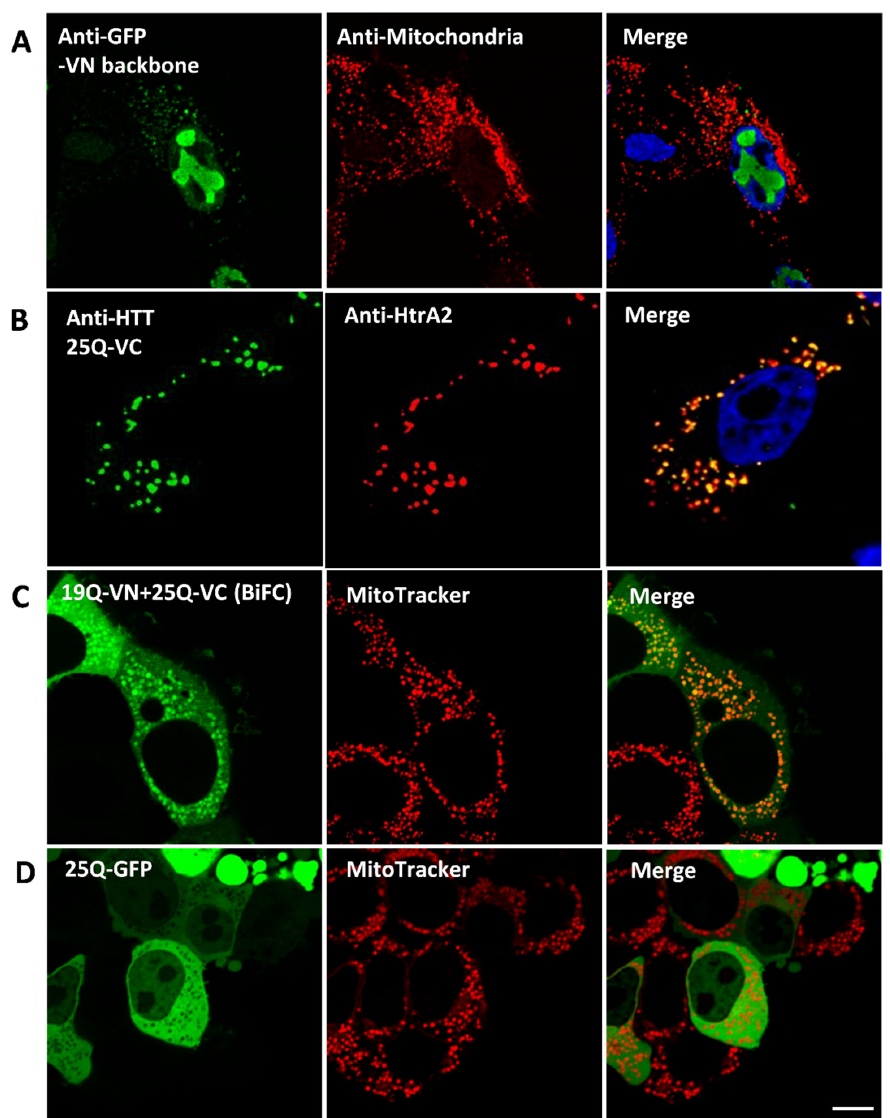
Figure 6. Fluorescence tag effect on wild type HTT subcellular localisation in fixed HEK293T cells transfected with various constructs for 48 h. ( A ) N-terminal half of Venus (VN) localisation in dual immunolabelled HEK293T cells. Left panel: anti-GFP (ab6556) (Alexa Fluor 555). Middle panel: anti-mitochondria antibody (MAB1273) (Alexa Flour 647). Right panel: merge of VN and mitochondrial signals, nuclei stained with Hoechst 33342. VN localises mostly in the nucleus, with minor punctate staining in the cytosol which co-localises with mitochondria. ( B ) Cells expressing 25Q-VC were double immunolabelled as follows: Left panel: anti-HTT (mEM48) antibody (MAB5374) (Alexa Fluor 647). Middle panel: anti-HtrA2/Omi antibody (AF1458) (Alexa Fluor 555). Right panel: merge of HTT and HtrA2 signals; nuclei were stained with Hoechst 33342. 25Q-VC co-localises with mitochondria. ( C , D ) Cells were seeded in ibiTreat dishes and co-transfected for 48 h with 19Q-VN and 25Q-VC ( C ) or 25Q-GFP ( D ). Live cells were stained with MitoTracker Red CMXRox (M-7512) prior to confocal examination. Acquired images were deconvolved. ( C ) Left panel: BiFC signal 19Q-VN and 25Q-VC. Middle panel: MitoTracker signal. Right panel: merge of BiFC and MitoTracker signals. BiFC signal of WT HTT is mitochondrial (indicated by the co-localisation with MitoTracker) as well as cytosolic. ( D ) Left panel: GFP signal showing the fused 25Q localisation. Middle panel: MitoTracker signal. Right panel: merge of the 25Q-GFP and MitoTracker signals. Scale bar = 8 µ m. 25Q-GFP is expressed in the cytosol, with complete exclusion of mitochondrial